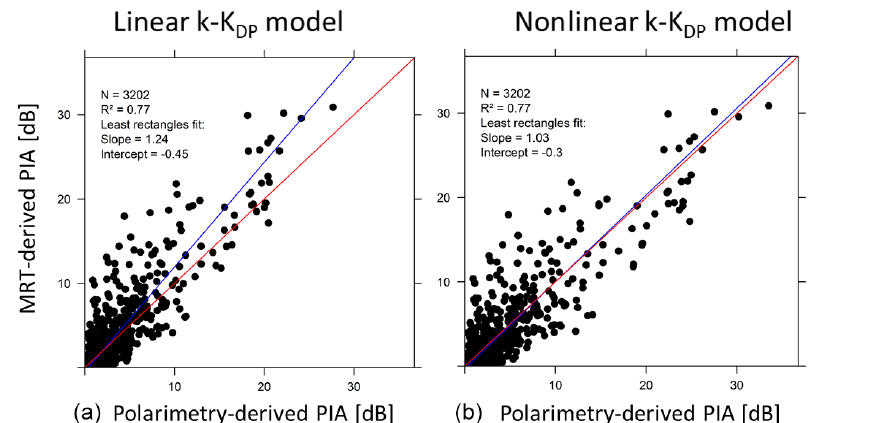
Figure 10. Comparison of the PIAs derived from the mountain reference technique and from polarimetry using the linear k – K dp relation- ship (a) and the nonlinear k – K dp relationship (b) for the nine convective events. The blue line corresponds to the least rectangle fit to the data and the red line is the 1 / 1 line.